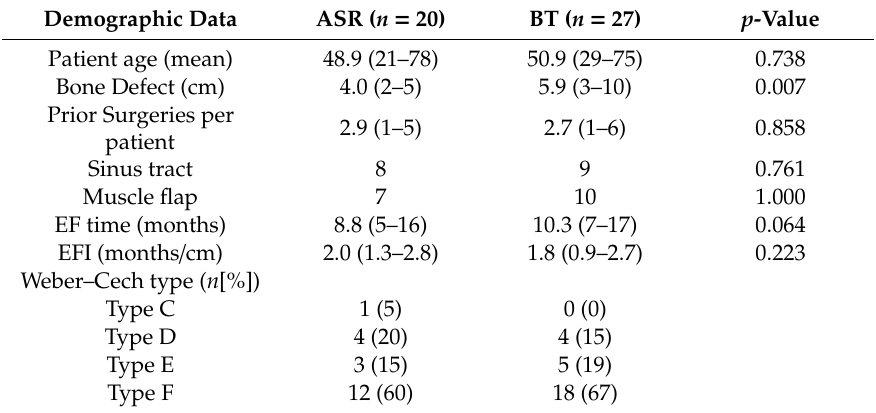
Table 1. Demographic data and surgical features of the study cohort stratified in groups with acute shortening and relengthening (ASR) and bone transport (BT). Values in bold are statistically significant. Demographic Data